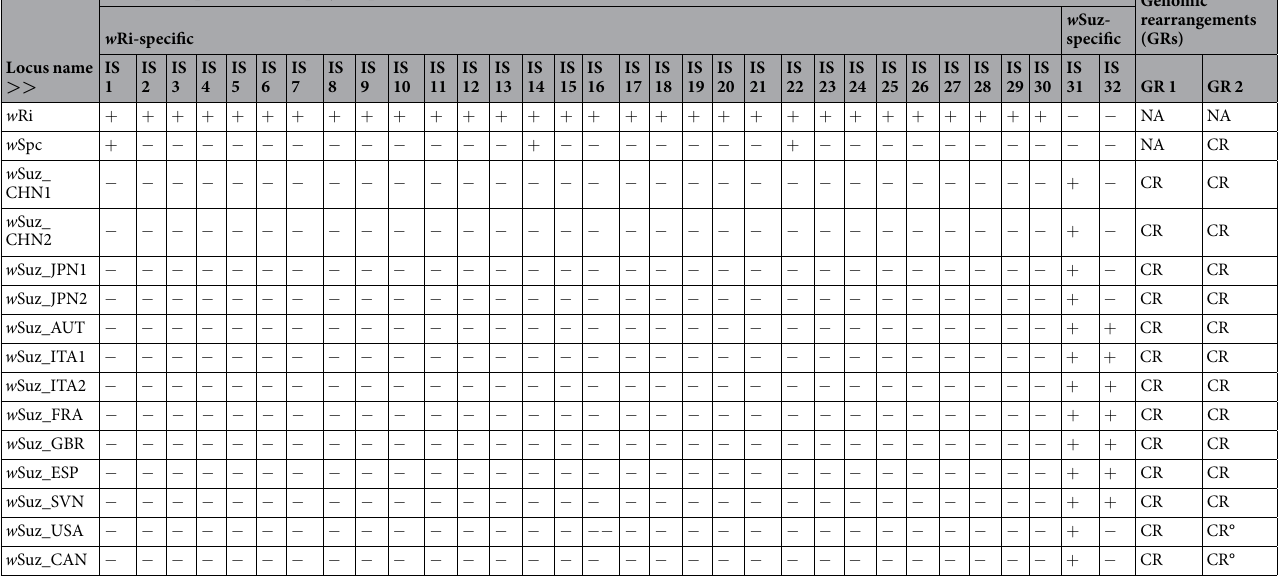
when passaged for several generations through heterozygous mutant lines of D . melanogaster 49 . Concurrent with